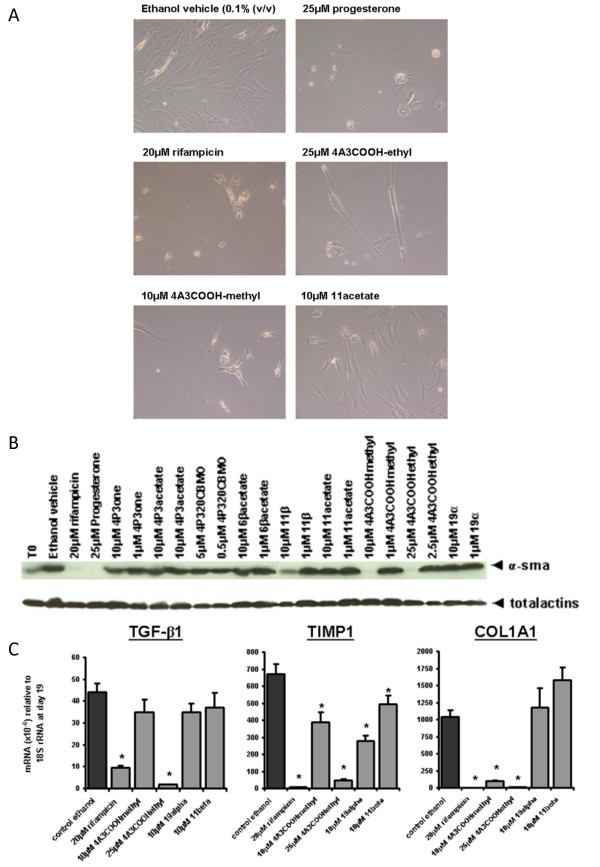
Screening for inhibitors of trans-differentiation in rat and human HSCs – Part 2. Photomicrographs of human HSCs at day 12 of culture with the indicated treatment (a); levels of expression of α-smooth muscle actin (α-sma) (b) and levels of expression of fibrogenic marker mRNA transcripts in human HSCs after treatment selected compounds for 19 days. Data are the mean and standard deviation relative transcript level from 3 separate treatments on cells from the same donor, typical of at least 3 separate donors (c).